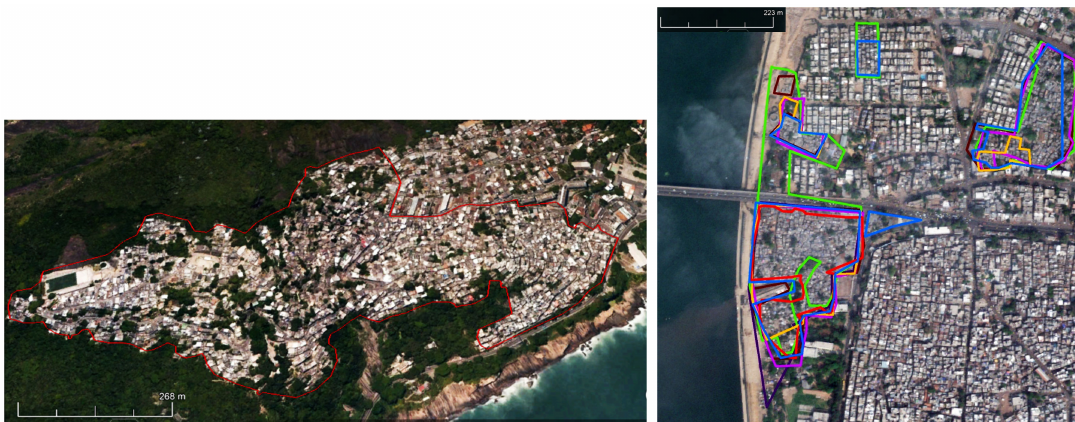
Figure 7. The complexity of drawing boundaries. ( Left ) the example of Rio de Janeiro, Brazil (red line municipal favela boundary in 2016); ( Right ) visual delineations of boundaries of deprived areas in Ahmedabad, India by several geospatial experts (different colors refer to different interpreters) (Image source: Google